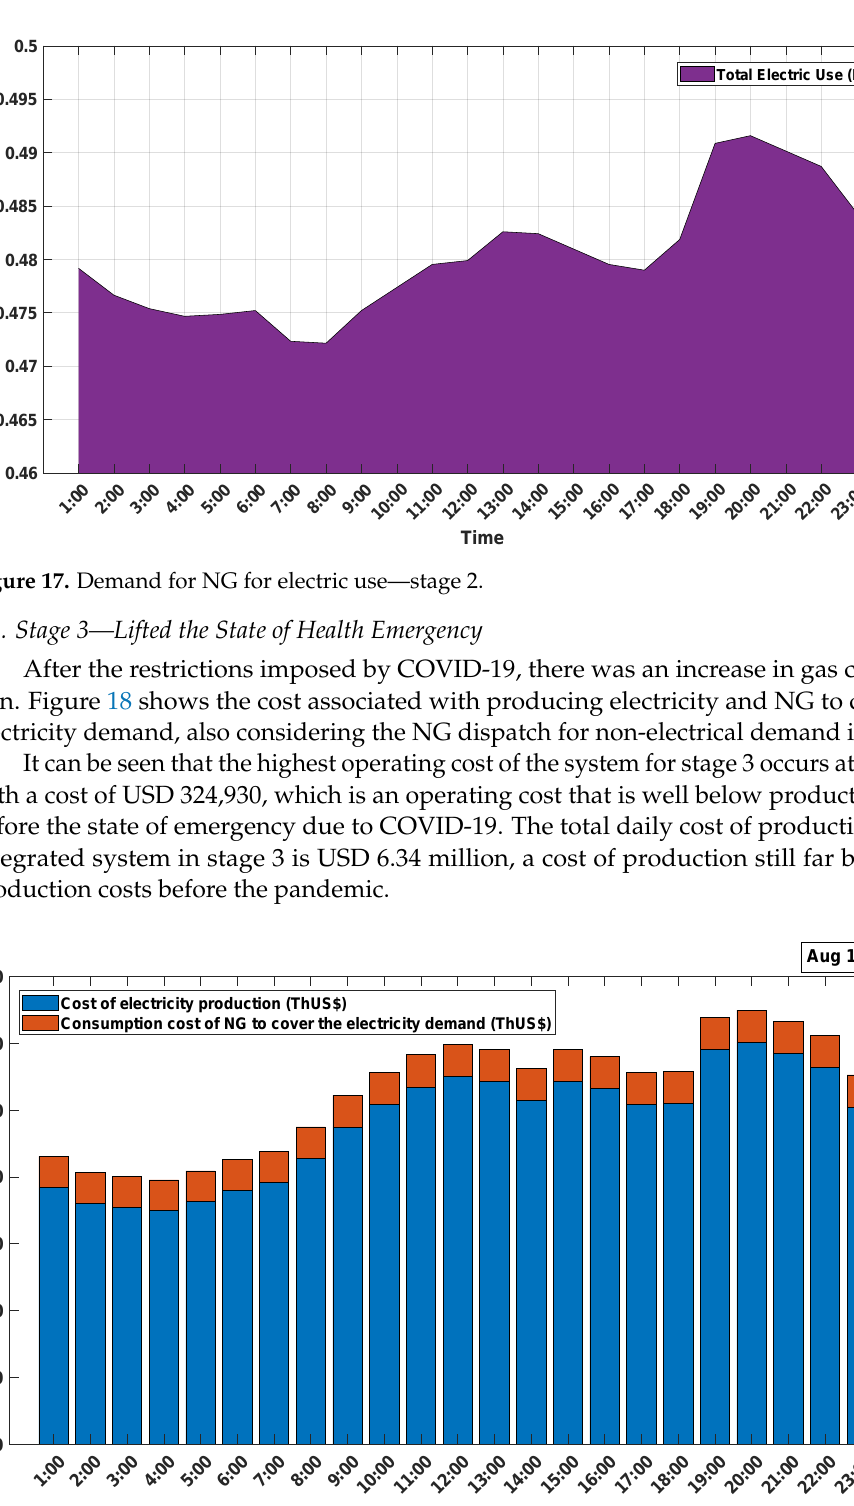
Figure 18. Optimal cost of energy production and ng supply and operation of the integrated gas– electricity system—stage